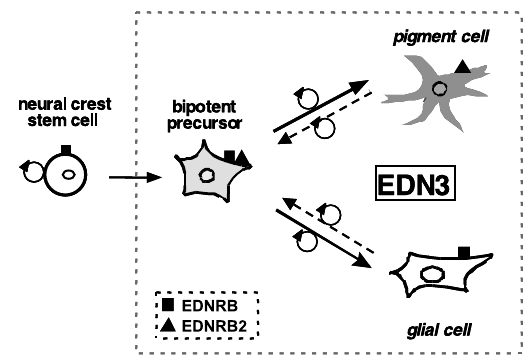
Fig. 4 – Summary of the action of EDN3 on NC precursors and NC-derived cells. EDN3 favor the survival and proliferation of bipotent glial-melanocytic progenitors derived from NC stem cellsintheearlyNC.ActivationbyEDN3ofthemelanogenicdif- ferentiation program involves the induction of EDNRB2 expres- sion by developing melanoblasts, whereas differentiating glial cells continue to express EDNRB.Whether the bipotent cells are able to co-express both types of receptors remains to be ascer- tained. At later stages, differentiated pigment cells in the epi- dermis and glial cells in peripheral nerves are able to revert to the immature bipotent stage of their common NC ancestor under prolonged in vitro exposure to